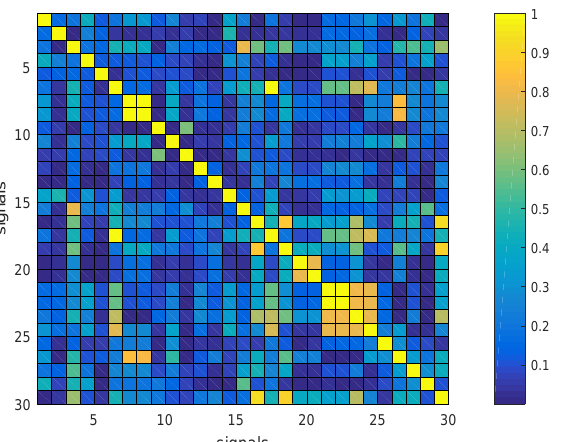
Figure 5. Visualization of the correlation matrix (absolute values of correlation are reported): each row and column stands for an available